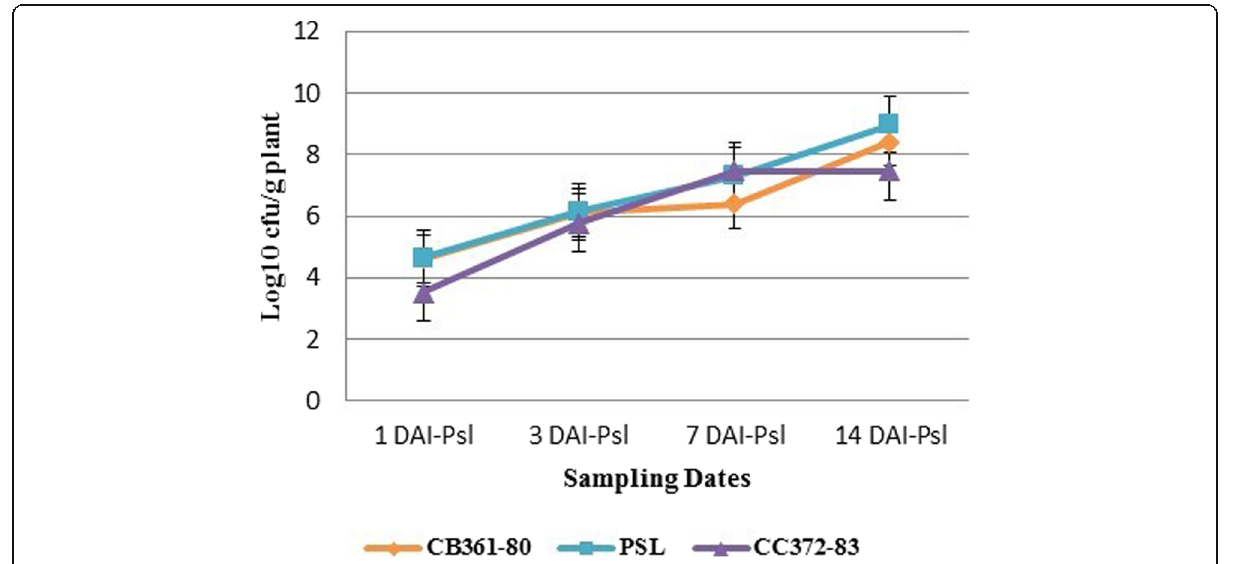
Fig. 3 Colonization of Pseudomonas syringae pv. lachrymans in cucumber plants not treated and treated with endophytic bacteria isolates CB361-80 and CC372-83 at different sampling dates according to (Table 2). The population data for graphs were transformed to log